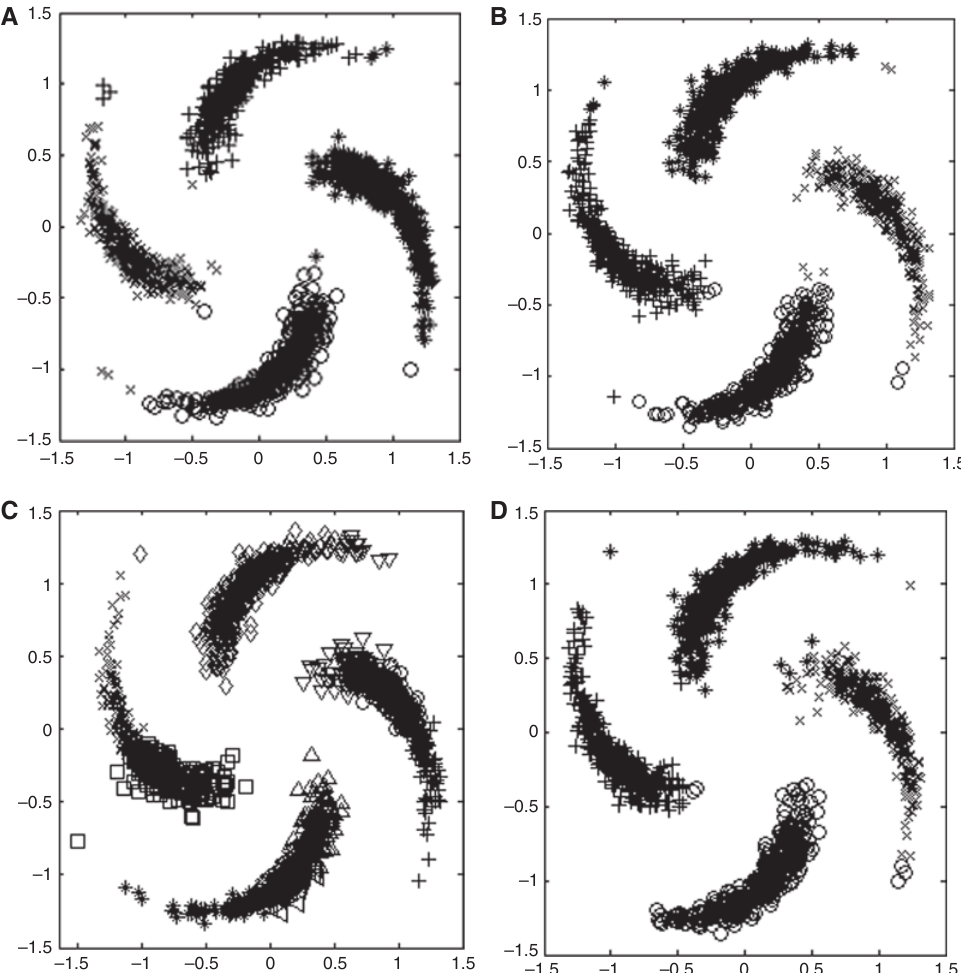
Figure 3: (A) Clustered Data 2 after the Application of KM for K = 4. (B) Clustered Data 2 after the Application of FCM for K = 4. (C) Clustered Data 2 after the Application of FCM for K = 9. (D) Clustered Data 2 after the Application of MHSC for K = 4.